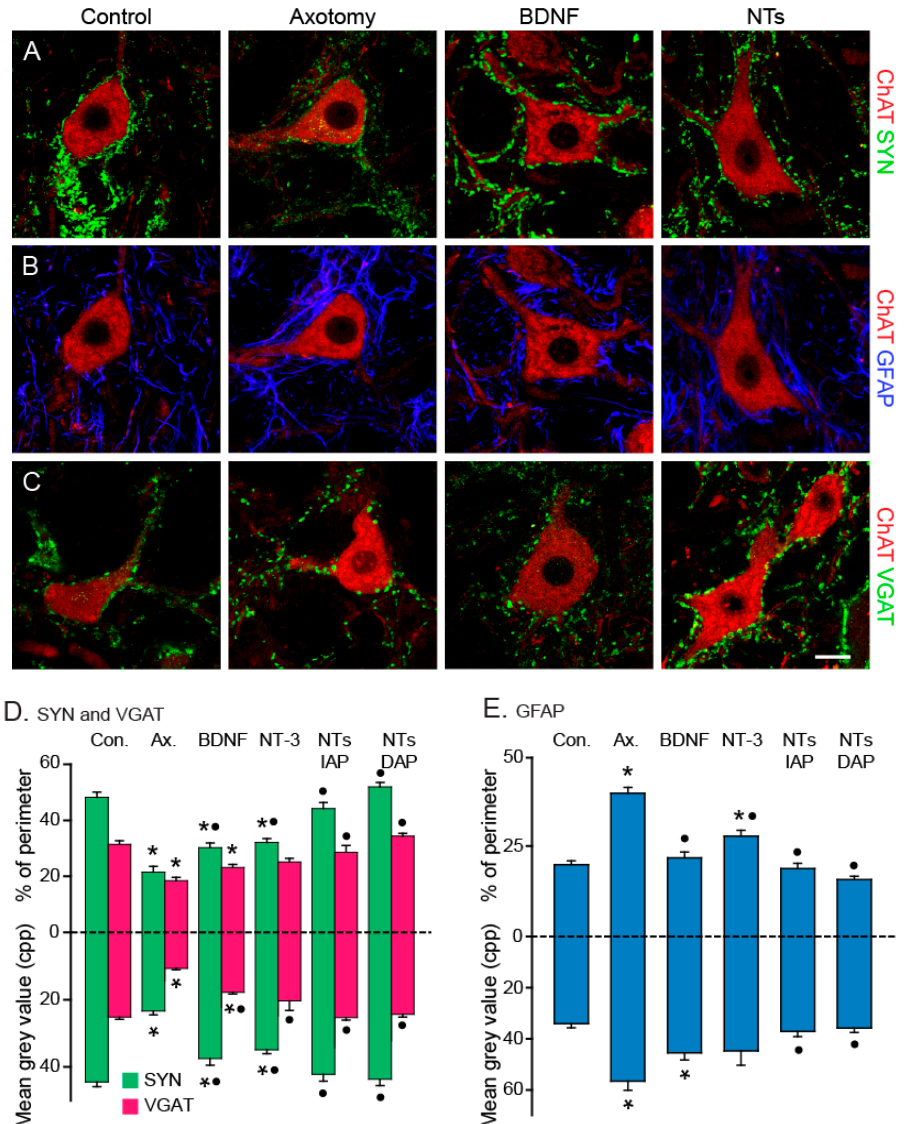
Figure 6. Neurotrophin involvement in prevention of synaptic stripping: ( A ) Confocal high-magnification images of motoneurons in control, axotomy, and after treatment with BDNF or with the mixture of BDNF+NT-3 (NTs), illustrating the synaptophysin (SYN) innervation in green and the motoneuronal cell body in red (ChAT). All images were obtained from animals after 15 days of axotomy alone or after treatment with neurotrophins in an immediate administration protocol (IAP); ( B ) Same treatments as in (A), but for GFAP coverage; ( C ) Confocal images of VGAT labeling in ChAT-identified motoneurons. Calibrations bar: 10 µm for ( A – C ); ( D ) Changes in SYN-immunoreactive (IR; green ) and VGAR-IR (Simbols to be erased) boutons in the abducens nucleus after axotomy (Ax.) and different treatments (Con., control). Up-directed bars represent the percent of covered perimeter of the motoneurons in control, axotomy, single neurotrophin treatment (BDNF or NT-3) and double neurotrophin treatment for either IAP or delayed administration protocol (DAP). Down-directed bars correspond to measurements in the neuropil. Bars represent mean ± SEM for 15–46 motoneuronal profiles in each group and 26 to 50 measurements in the neuropil; ( E ) Same as in ( D ) but for measurements of GFAP-IR profiles around somata (up directed bars) or in the neuropil (down-directed bars). Asterisks indicate significant differences with control, whereas dots indicate significant differences with axotomy. Two way ANOVA, Holm–Sidak method for pairwise multiple comparisons ( p < 0.01). Modified from [105].